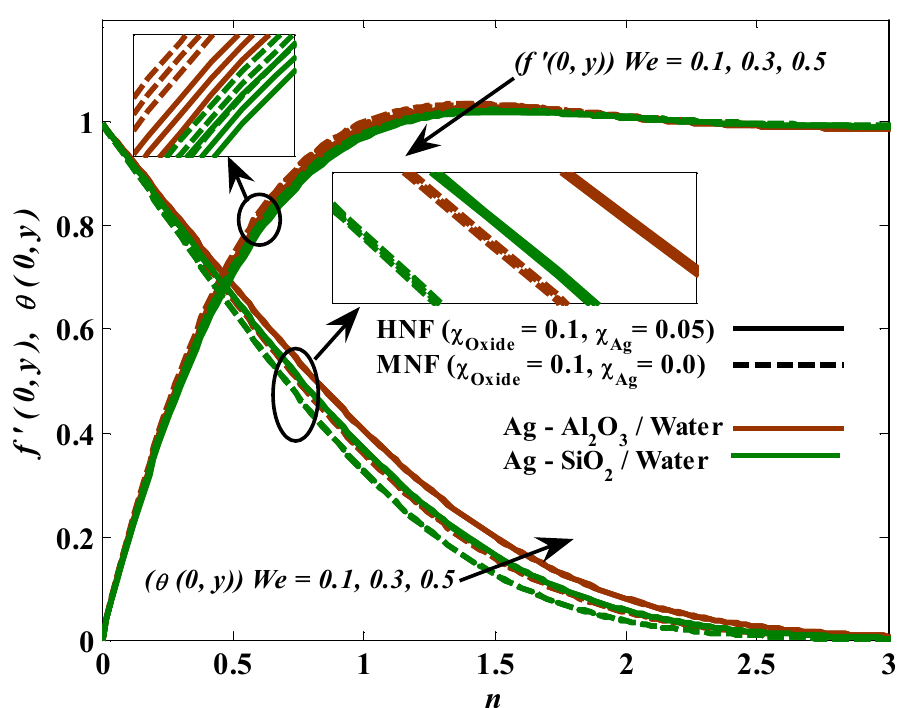
Figure 14. Illustration of We versus temperature and velocity at fixed values of λ = 0.2, R = 0.1, & M = 1.